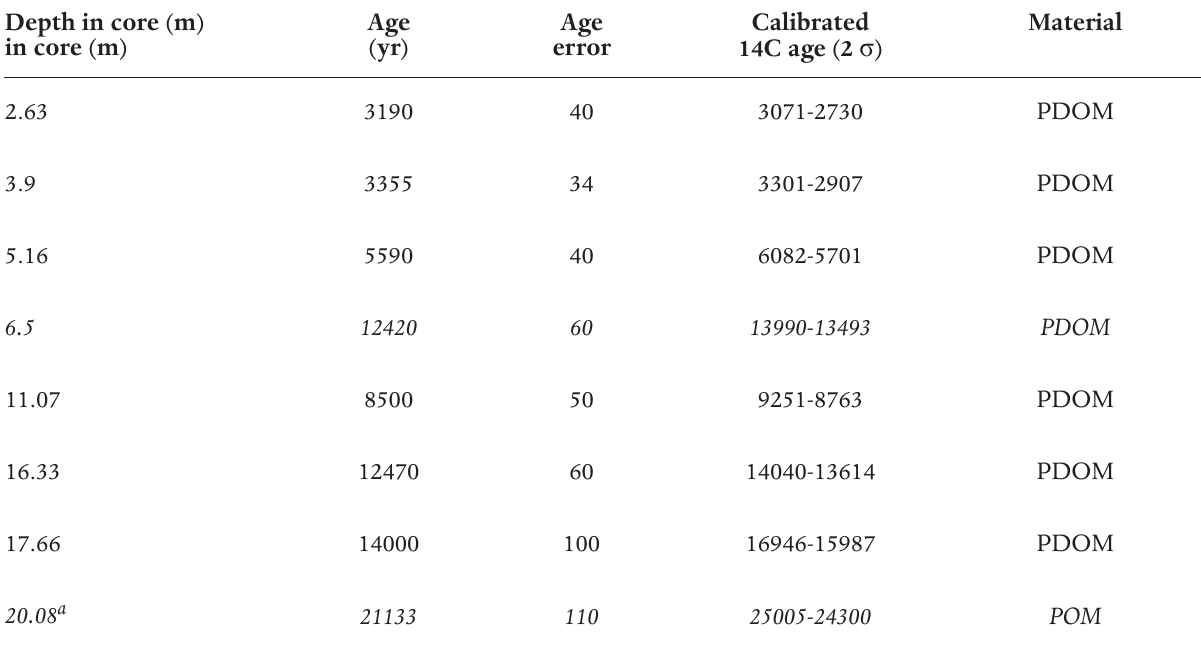
Table 1. Radiocarbon dating from the MD01-2477 core. The sample denoted by the letter “a” was carried out by Lykousis et al. [2007]. The 14 C ages were calibrated using OxCal software [Bronk Ramsey 2001], the Marine09 calibration curve [Reimer et al. 2009]; and applying the local marine reservoir correction ( Δ R) proposed by Reimer and McCormac [2002] for Aegean Sea. Samples in italic overestimate the ex- pected age. PDOM= plant debris and wood fragments extracted from fine and coarse turbidites; POM= particulate organic matter extracted from organic rich